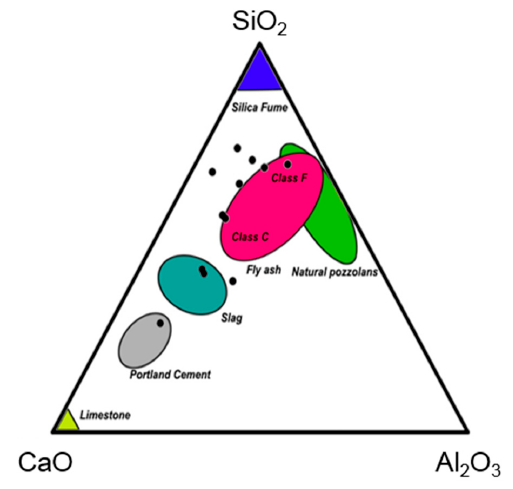
Figure 5. Composition of bottom ash from various incinerator facilities (black dots) superimposed on other materials commonly used in construction cf. [6,28,32,35,40–50].